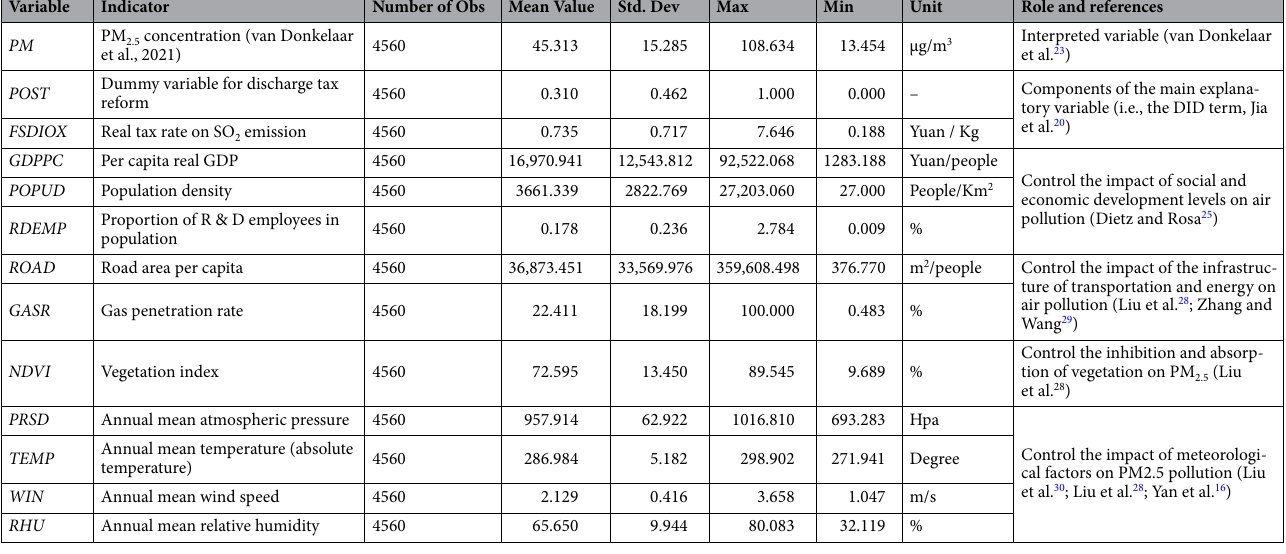
Table 1. Descriptive statistics.